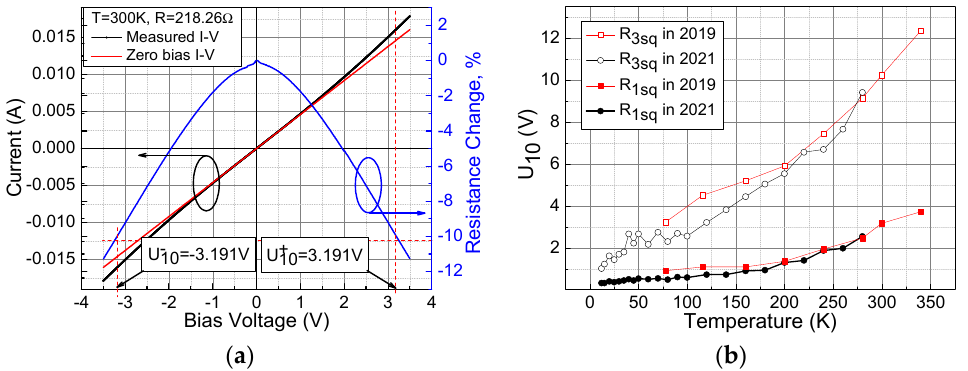
Figure 3. Cu-TiN x O y resistors non-linearity: ( a ) definition of the non-linearity parameter U 10 , which is the voltage that causes the differential resistance 10% change compared to its value at zero bias. In this particular example of I-V curve for 1-square long resistor measured at room temperature, U 10 = 3.191 V. ( b ) Resistors non-linearity parameter U 10 as a function of temperature measured 18 months apart.